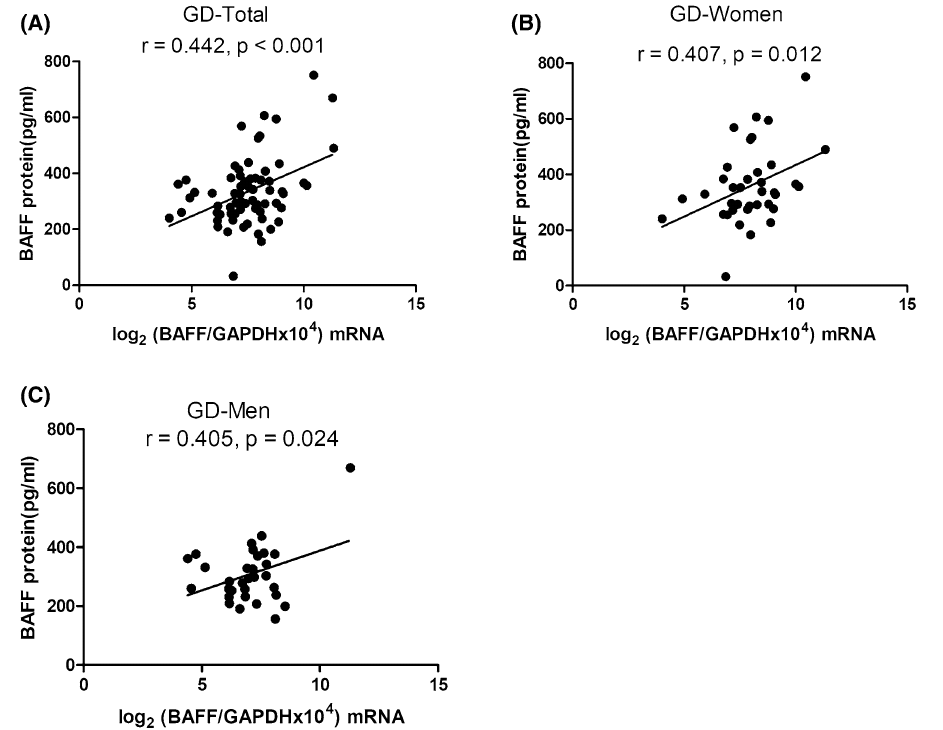
Figure 3. Correlations between serum B-cell-activating factor (BAFF) levels and BAFF mRNA levels in ( A ) all, ( B ) female, and ( C ) male Graves’s disease (GD) patients. p < 0.05 indicates statistical significance.